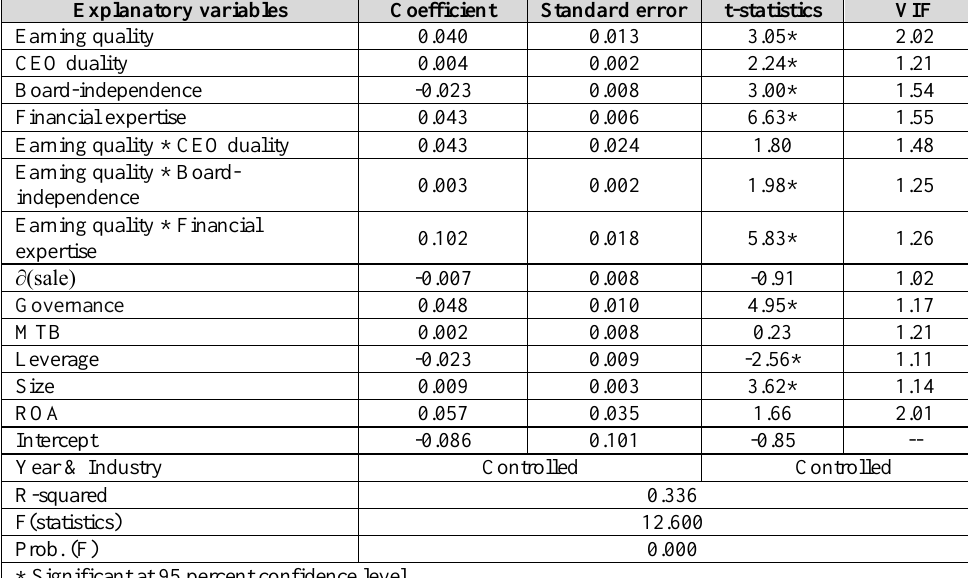
Table 3. H2 test